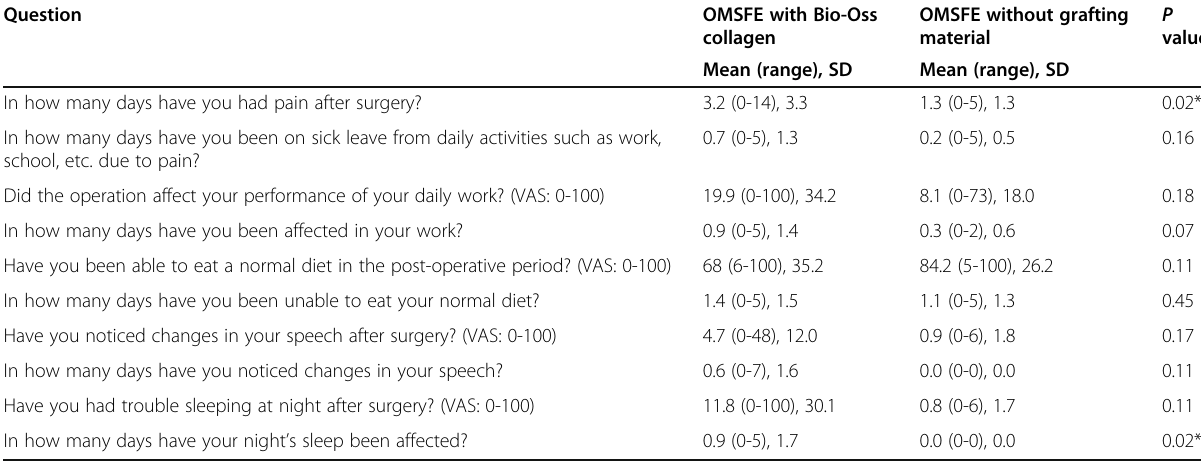
Table 7 Questionnaire assessing pain, sick leave, performance, ability to eat, sleep, and speak at 1 month Question OMSFE with Bio-Oss